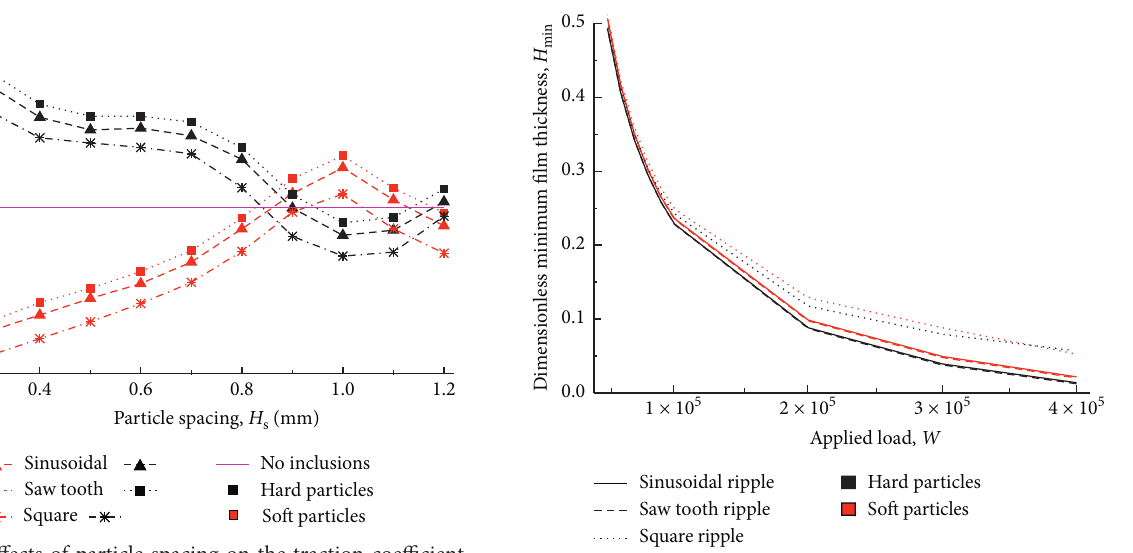
Figure 14: Nondimensional minimum film thickness with dif- ferent applied loads.